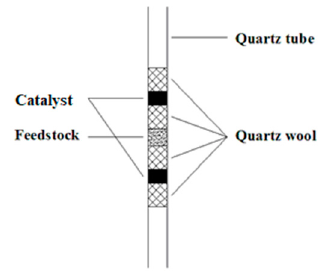
Figure 11. Diagram of quartz tube.